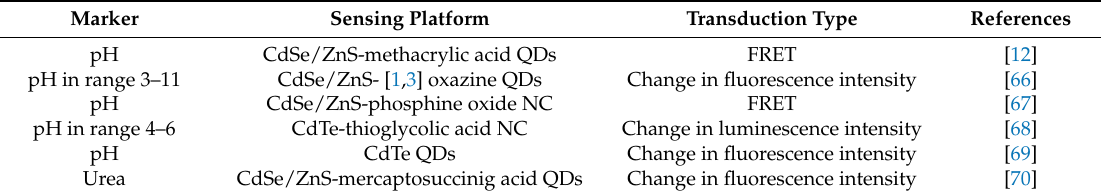
Table 2. QDs-based sensors for pH